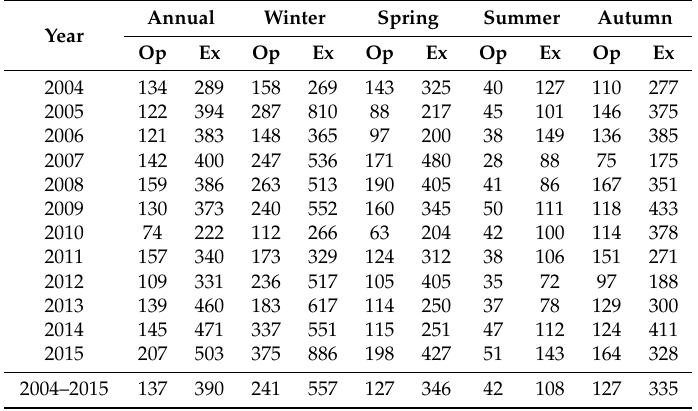
Table A12. Annual and seasonal Op and Ext P thresholds (kW/m) at